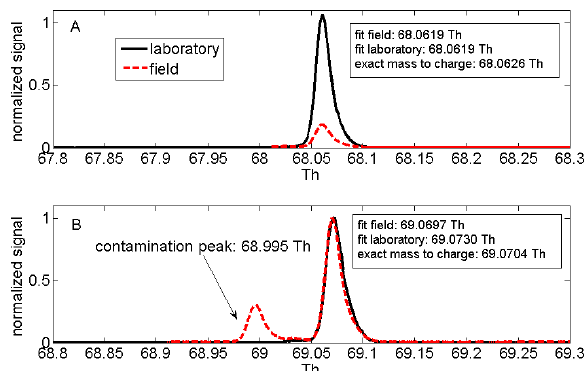
Fig. 2. Observed mass spectra for field and laboratory measure- Figure 2.Observed mass spectra for field and laboratory measurements depicting the 2 ments depicting the molecular ion distribution on m/z 68 + Th (A) molecular ion distribution on m/z 68 + Th (panel A) and m/z 69 + Th (panel B). Spectra are 3 and m/z 69 + Th (B) . Spectra are normalized by the 232MBO count normalized by the 232 MBO count rate. 4